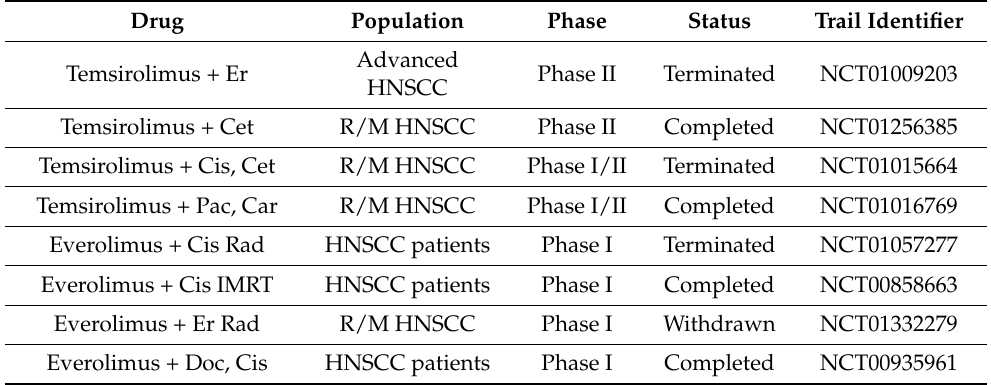
Table 1. Clinical investigations evaluating the efficacy of mTOR inhibitors in a combination for the treatment of